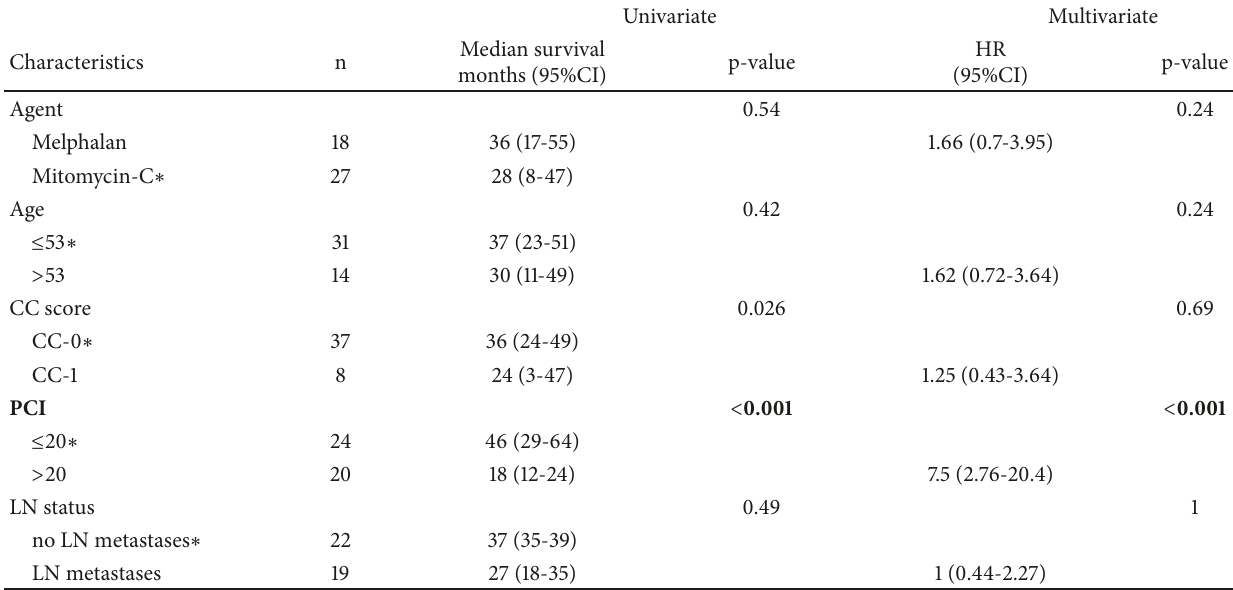
Table 2: Univariate and multivariate analysis of survival in patients with colorectal cancer, treated with melphalan or mitomycin-C as a HIPEC agent.